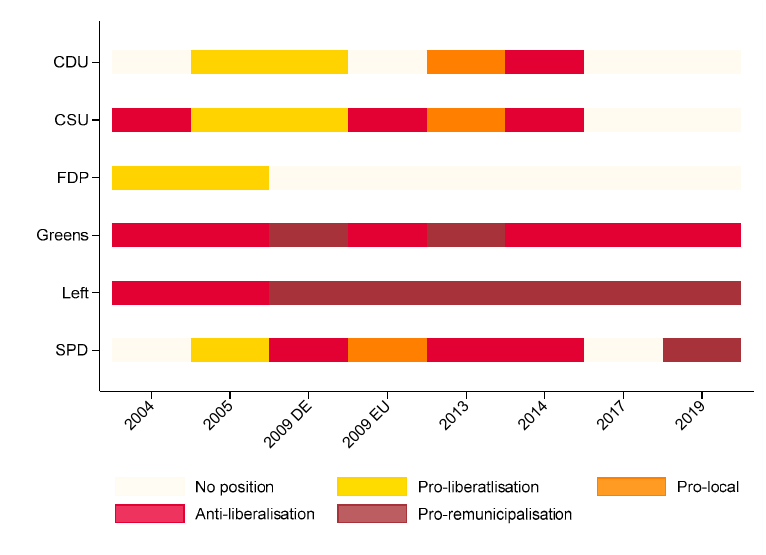
Figure 2. German parties’ statements on the governance of water services.